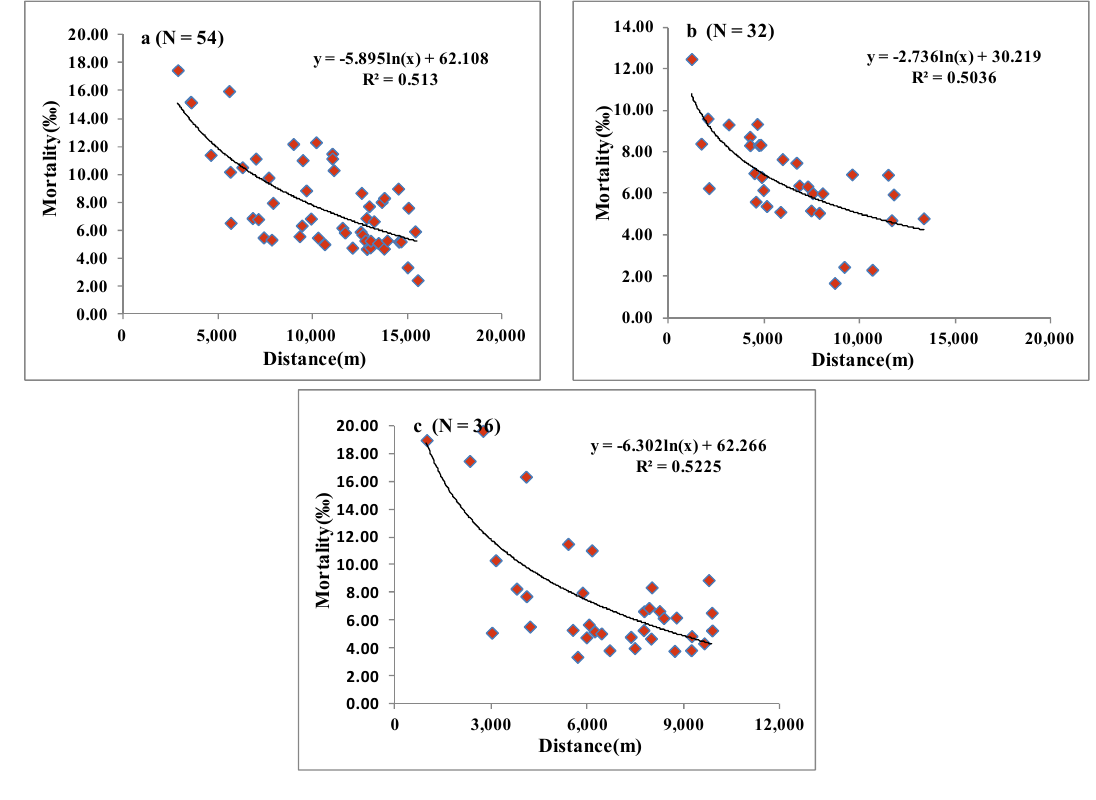
Figure 5. Relationship between mortality in Suxian District and distance from Shizhuyuan ( a ) DJT smelters ( b ) and Xianxichong ( c ) mining sites of Chenzhou City, South